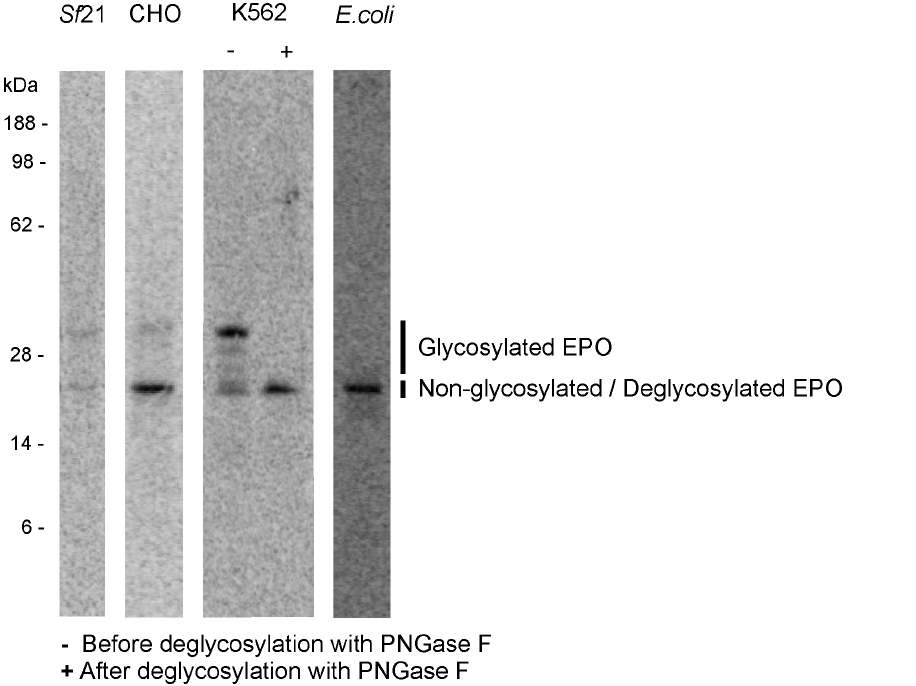
Figure 7. Expression of the glycoprotein EPO in prokaryotic and eukaryotic cell-free systems. Eukaryotic expression was performed using the EasyXpress pIX3.0 vector equipped with the CrPV IGR IRES (GCU). In the case of the K562-based cell-free expression, EPO is presented before ( 2 ) and after ( + ) deglycosylation with PNGase F. For prokaryotic expression, the native signal peptide of EPO was replaced by the melittin signal sequence and cell-free expression of the target protein was operated using the EasyXpress pIX2.0 vector. 14 C-leucine-labeled, de novo synthesized EPO (21 kDa, non-glycosylated) was visualized by autoradiography after gel electrophoresis.